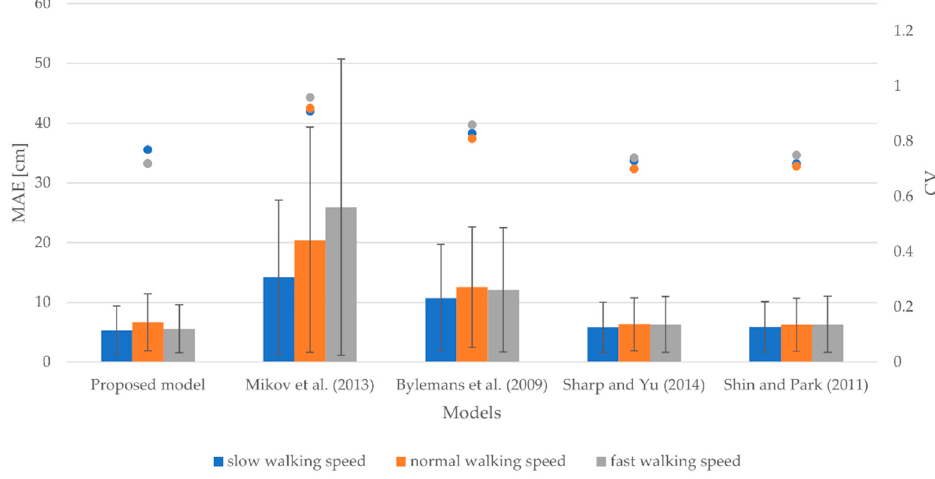
Figure 4. MAEs, SDs, and CVs for slow, normal, and fast walking speeds considering the smartphone attached to the